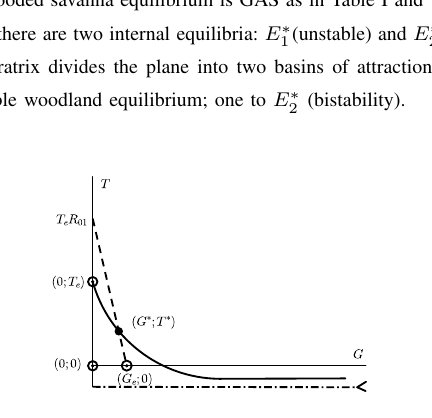
Fig. 3: Different equilibria and their stability/instability properties when R 01 > 1 and ω ( G e ) R 10 < 1 . Same as in Fig 1 , there are four equilibria and only coexistence equilibrium is